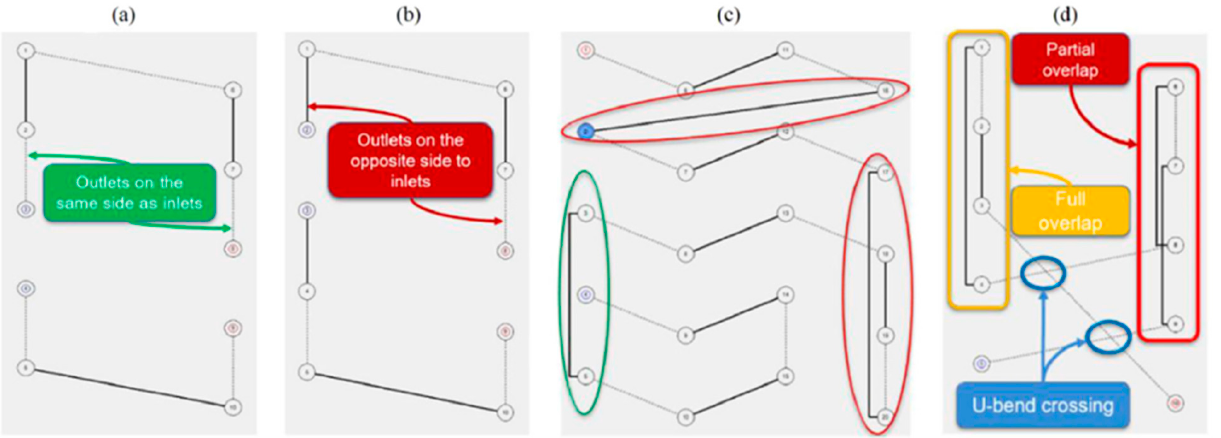
Figure 24. Manufacturing restrictions: ( a ) outlets on the same side as inlets; ( b ) outlets on the opposite side to inlets; ( c ) long bends; ( d ) different kinds of bend crossovers [106].